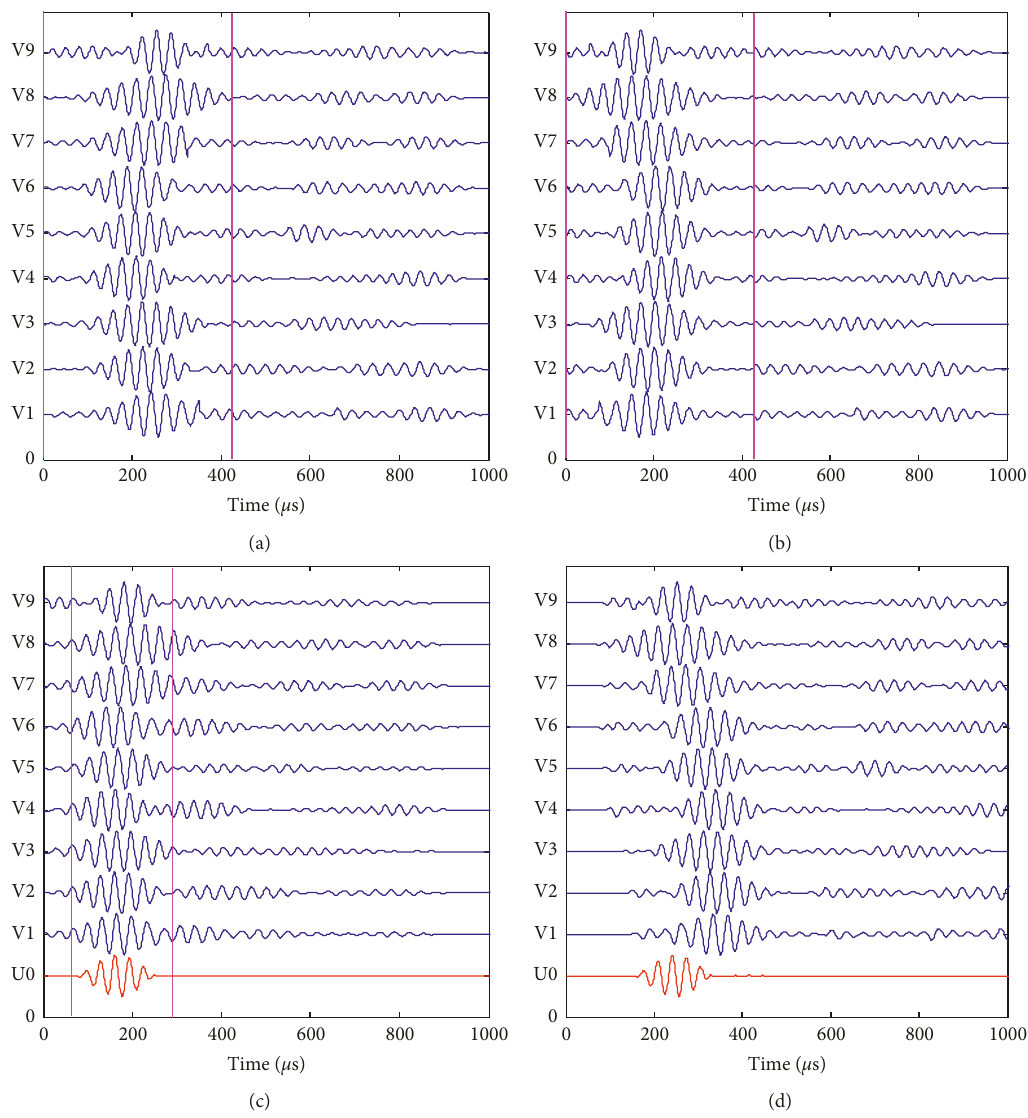
Figure 14: Focusing of the direct and adjoint sound fields at the defect: (a) scattered signals received by all receiving sensors; (b) scattered signals after time reversal; (c) scattered signal reaching the defect; (d) scattered signal reaching the nondefective